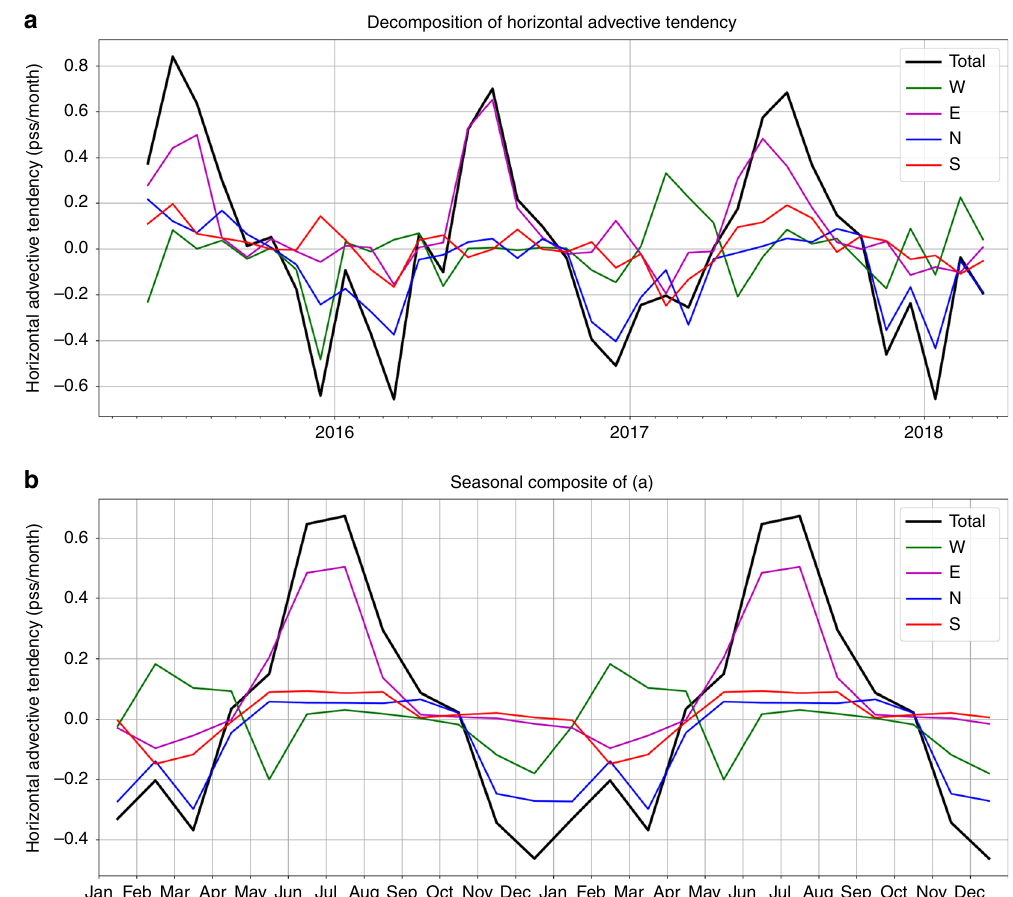
Fig. 8 Decomposition of horizontal advective tendency. The total (black) horizontal advective tendency is divided into the contributions through the Western (green), Eastern (purple), Northern (blue), and Southern (red) interfaces. a Time series for the 3-year period of the study. b Seasonal cycles by averaging the values of the same month from different years. The seasonal cycles were plotted twice to facilitate the